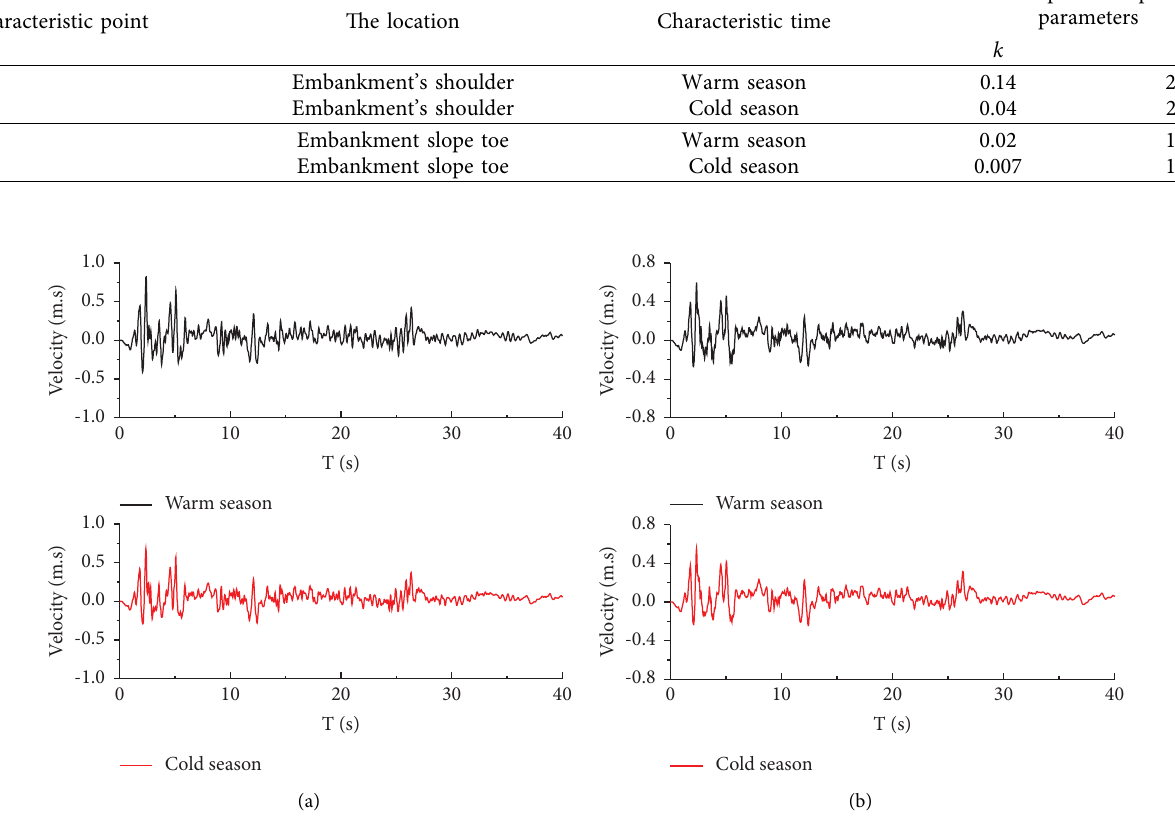
Figure 8: Te velocity time history curve of the characteristic point in diferent seasons: (a) characteristic point S ; (b) characteristic point T .